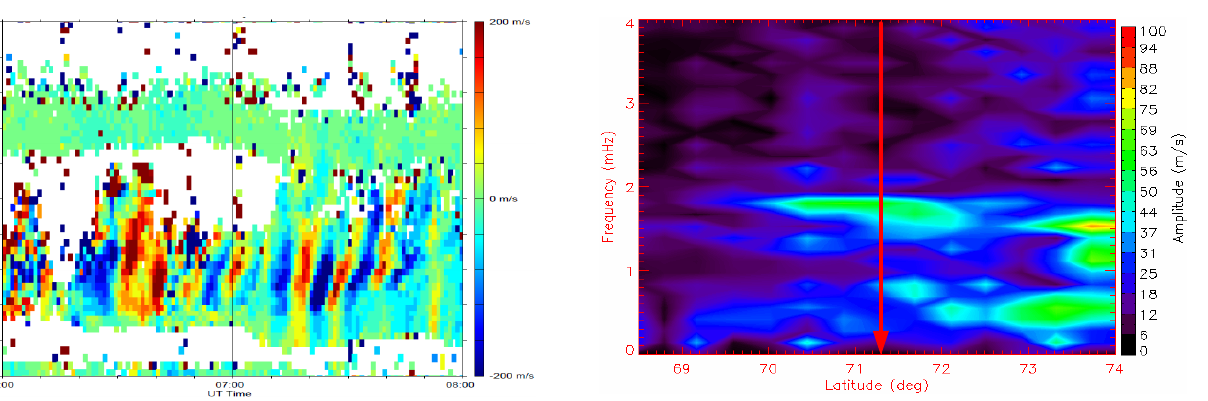
Fig. 3. The instantaneous amplitude (a) and phase (b) of the 1.9 mHz component as a function of latitude from Goose Bay data calculated as the amplitude and phase of the analytic signal